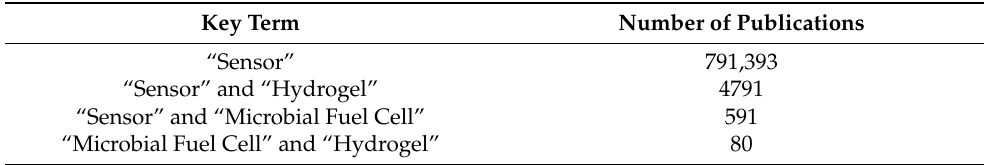
Table 1. Advanced keyword and search terms applied to the Web of Science database and the number of publications